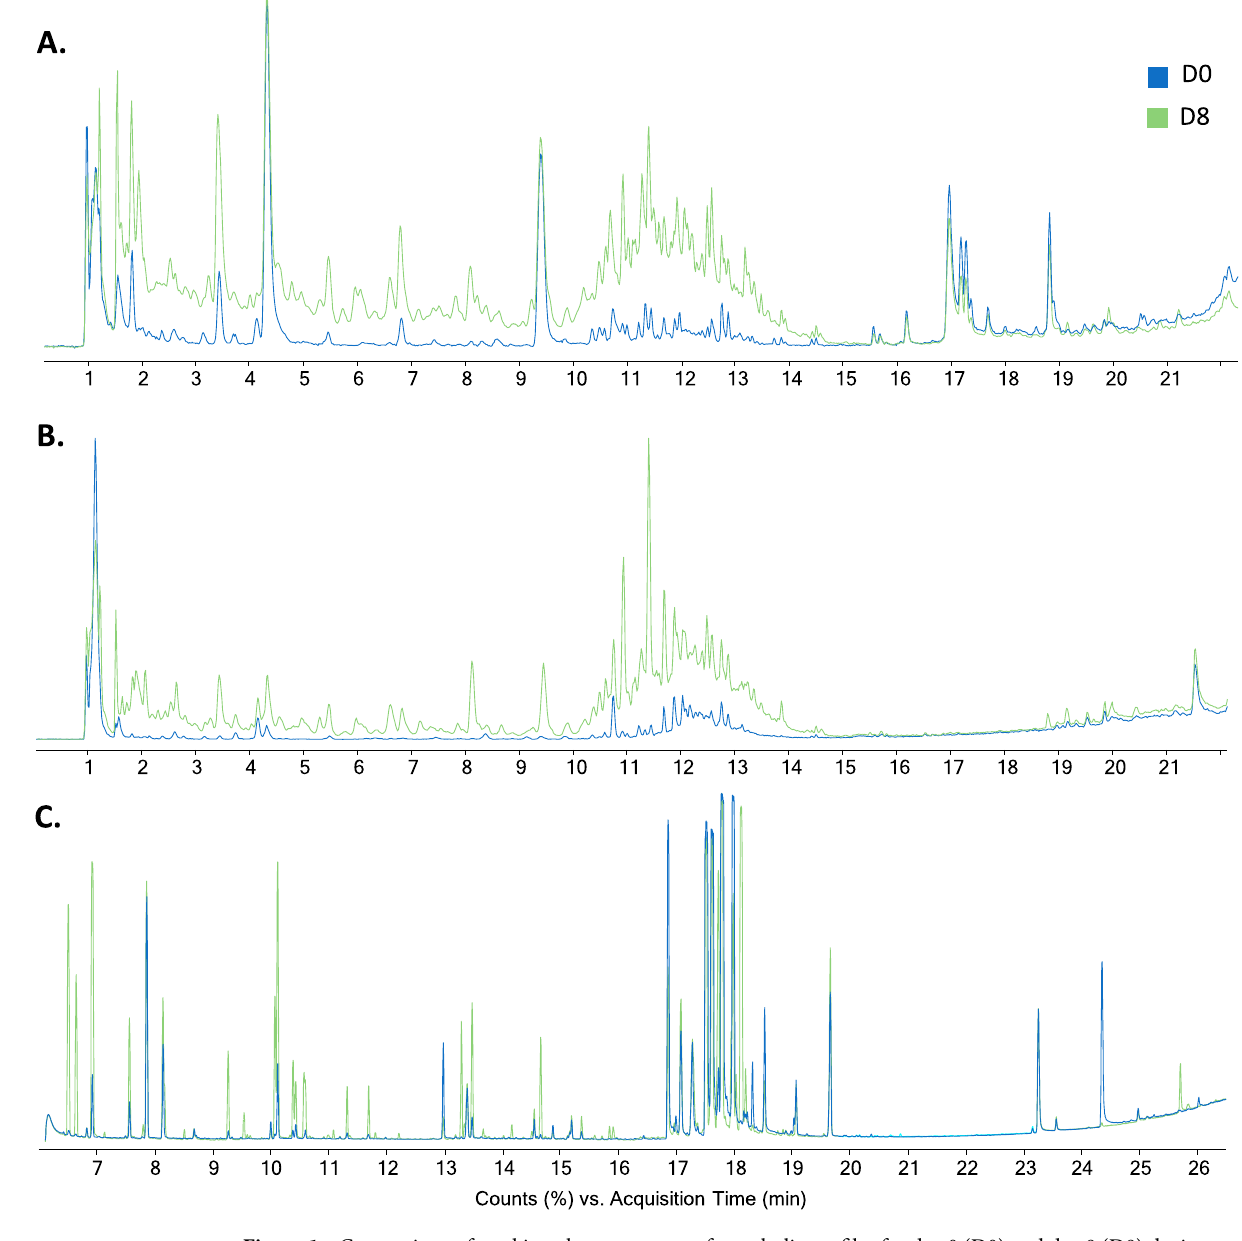
Figure 1. Comparison of total ion chromatogram of metabolic profiles for day 0 (D0) and day 8 (D8) during fermentation of fine-flavor cocoa. ( A ) Metabolic fingerprinting (MF) by LC–MS( +); ( B ) MF by LC–MS(-); ( C ) MF by